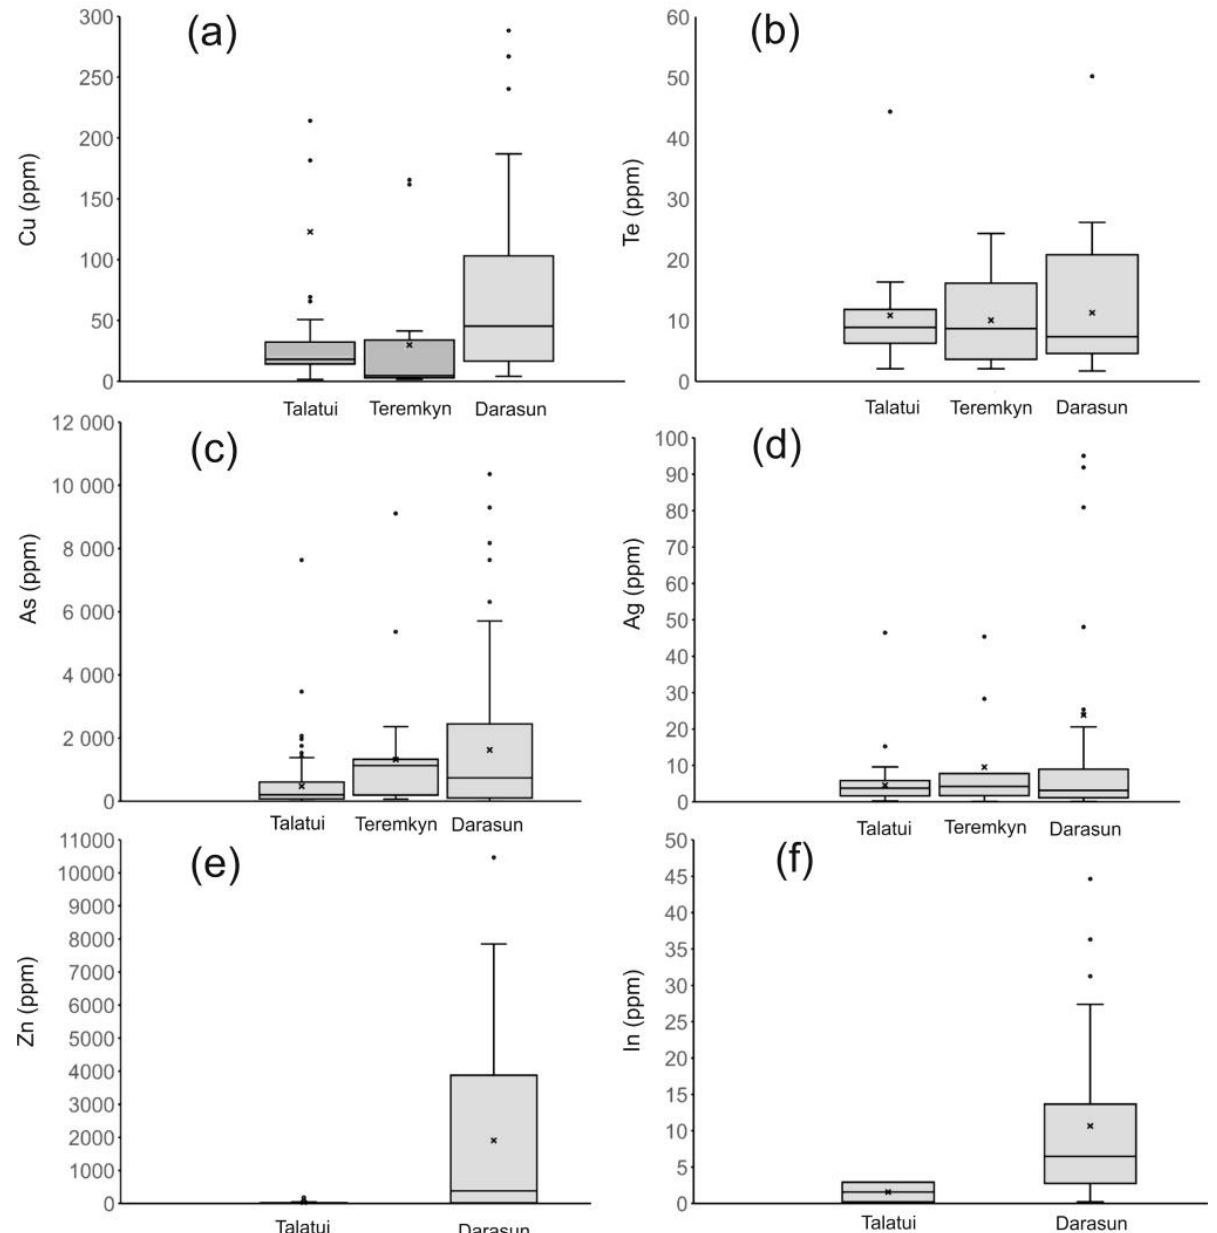
Figure 10. Boxplot diagrams of elements whose concentrations increase with a temperature decrease: a —Cu, b —Te, c —As, d —Ag, e —Zn, f —In.